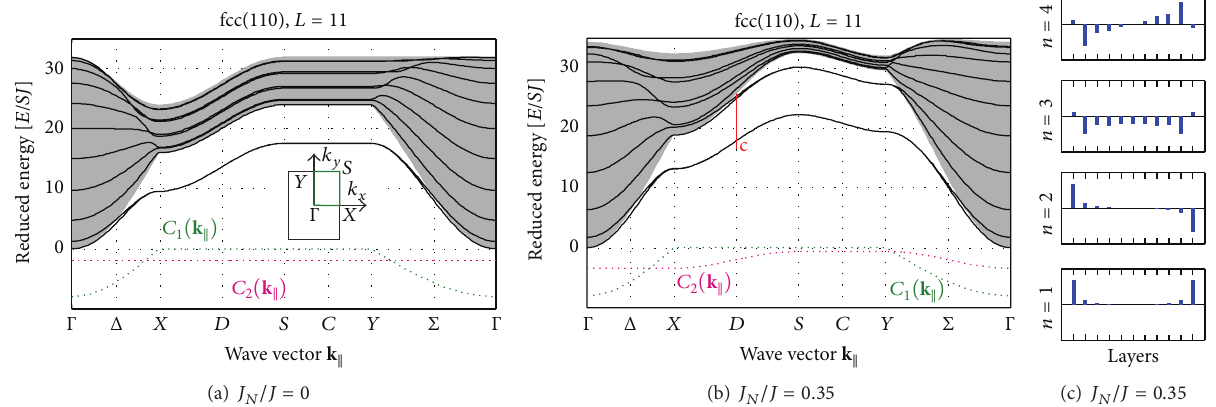
Figure 4: ((a), (b)) Spin-wave spectra of an 11-layer thick fcc(110) thin film (a) without and (b) with NNN exchange interactions. Solid lines represent the energy of individual modes; the shaded area is the bulk band for in-plane spin waves. Each spectrum is plotted along the high- symmetry path shown in (a), inset, and accompanied with the evolution of off-diagonal elements 𝐶 1 (green dotted line) and 𝐶 2 (purple dotted line) of the Hamiltonian matrix. (c) Mode profiles of the four lowest modes corresponding to the point 𝐷 in the SBZ, marked with a red line in